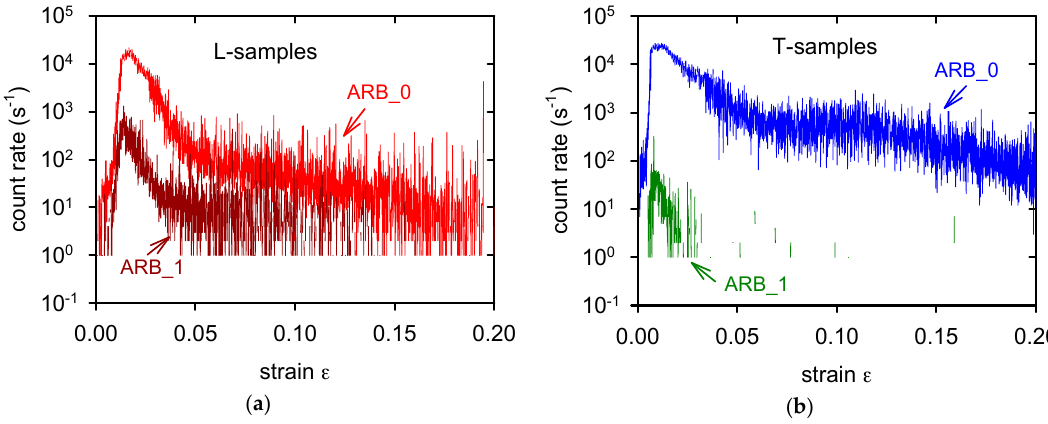
Figure 13. Acoustic emission rate measured during deformation of the L-samples ( a ) and T-samples ( b ).